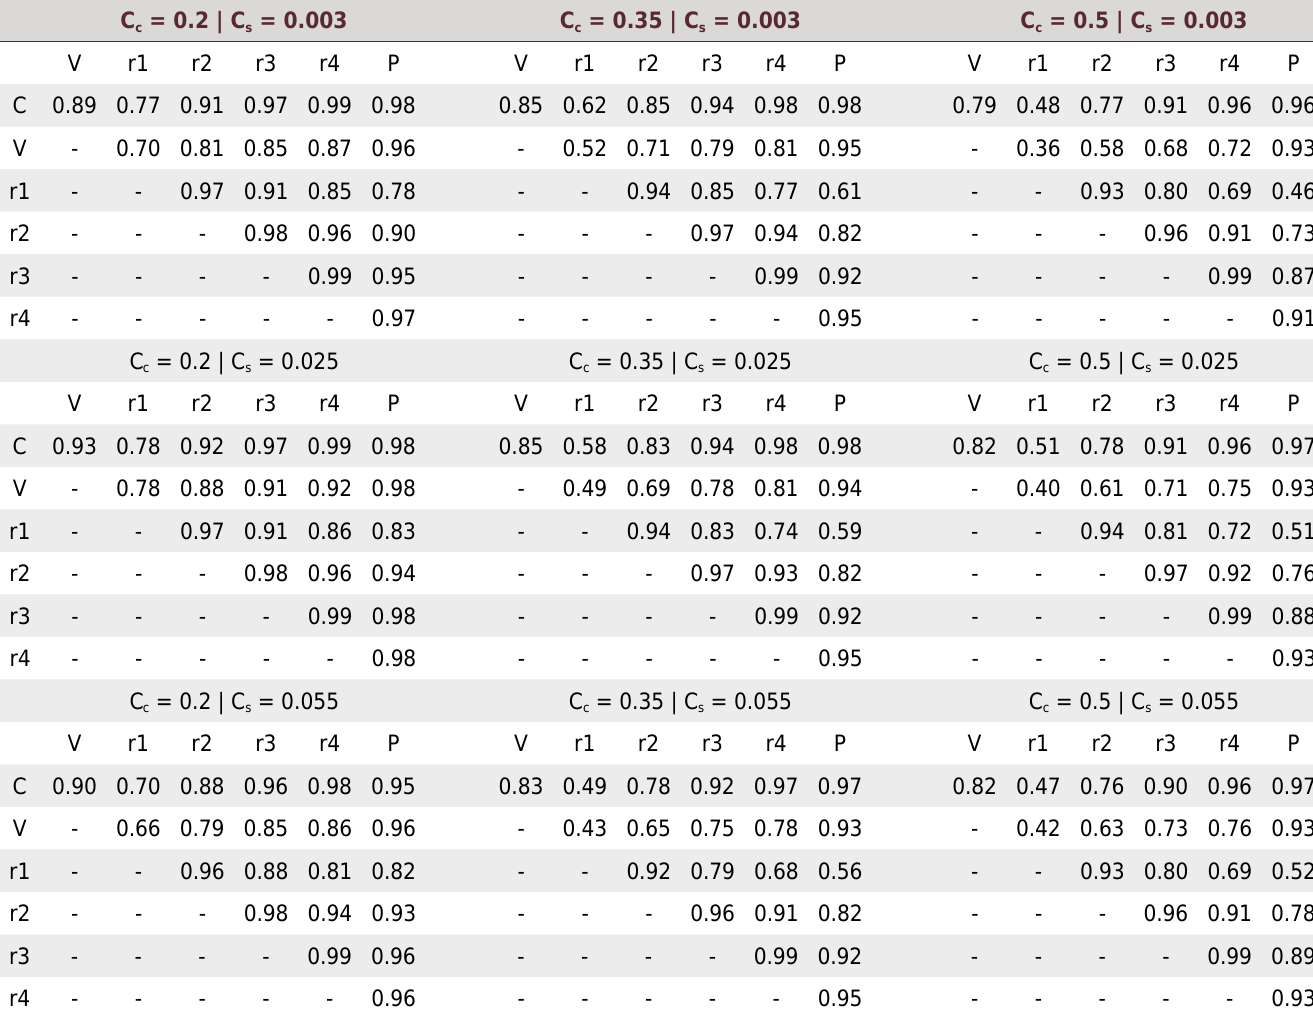
Table 2. Correlations among seven methods (C: Casagrande; V: VCLzero; r1, r2, r3, r4: regression methods; P: Pacheco Silva) of determination of σ p under nine scenarios designed according to the compression (C c ) and swelling (S s ) indices. Results based on 1,000 simulated soil compression curves C c = 0.2 | C s =